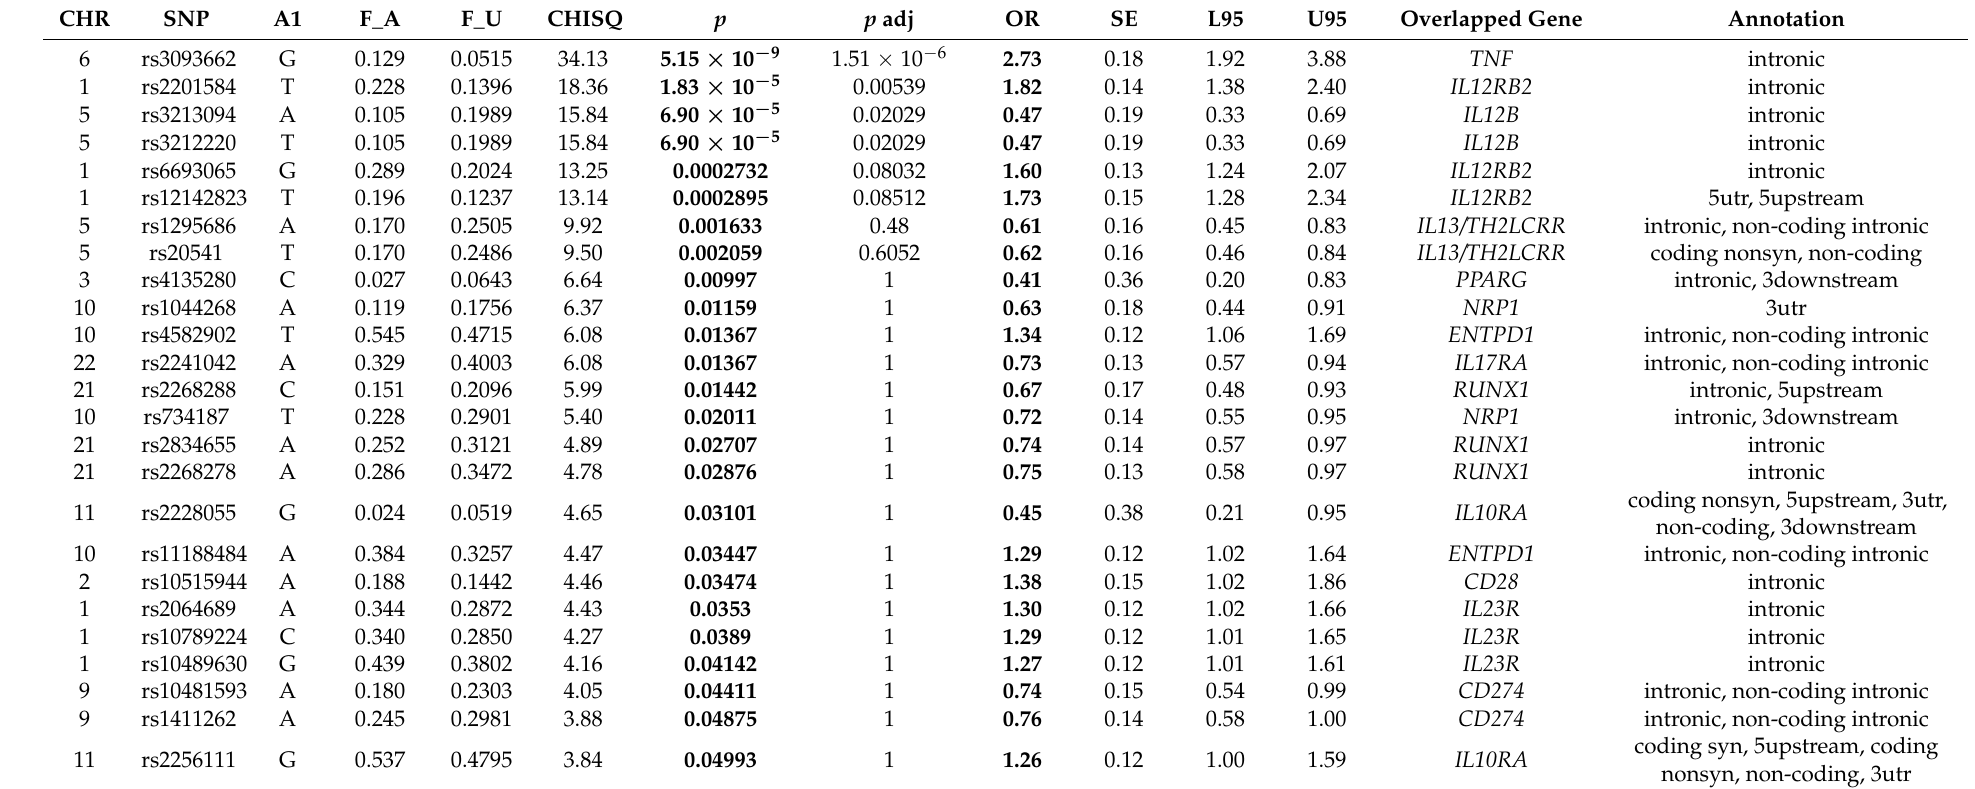
Table 2. Comparison of the frequency of SNPs in the group of patients with type I PsO and the control